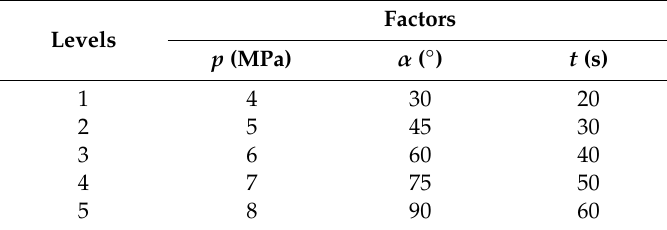
Table 7. Factors and levels of orthogonal experimental design.